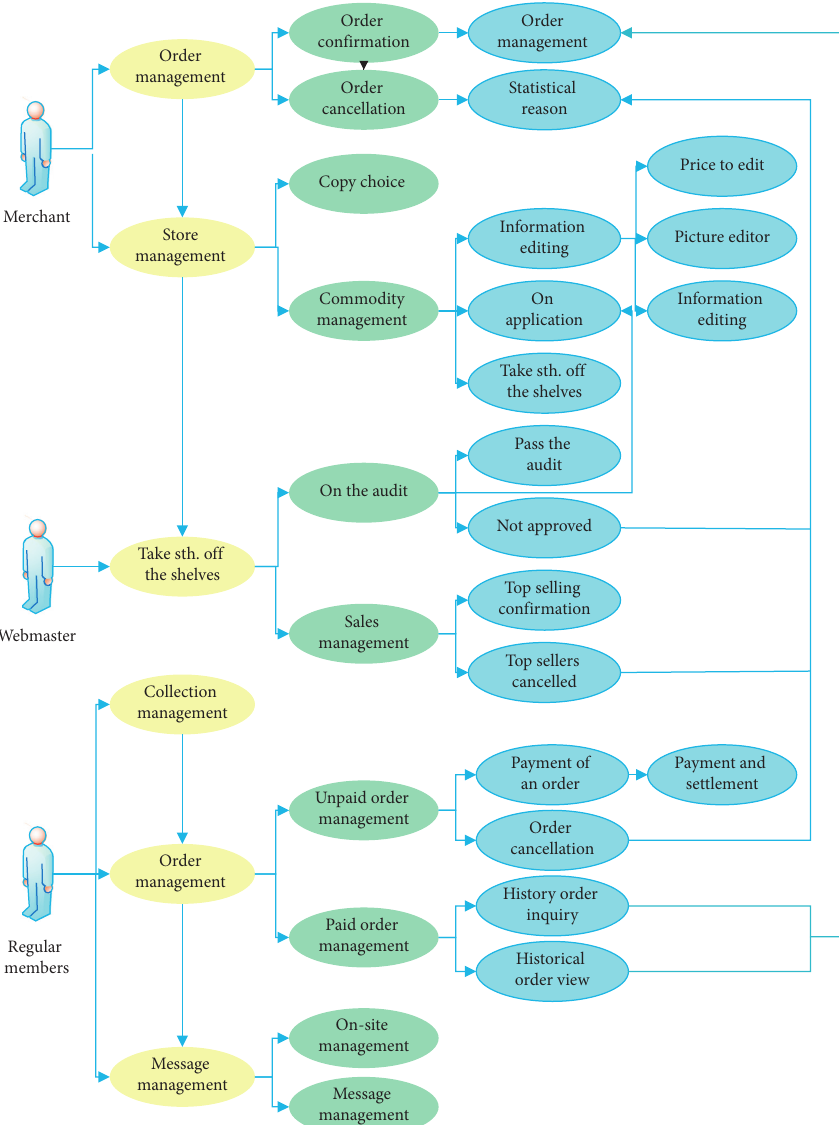
Figure 3: E-commerce flow